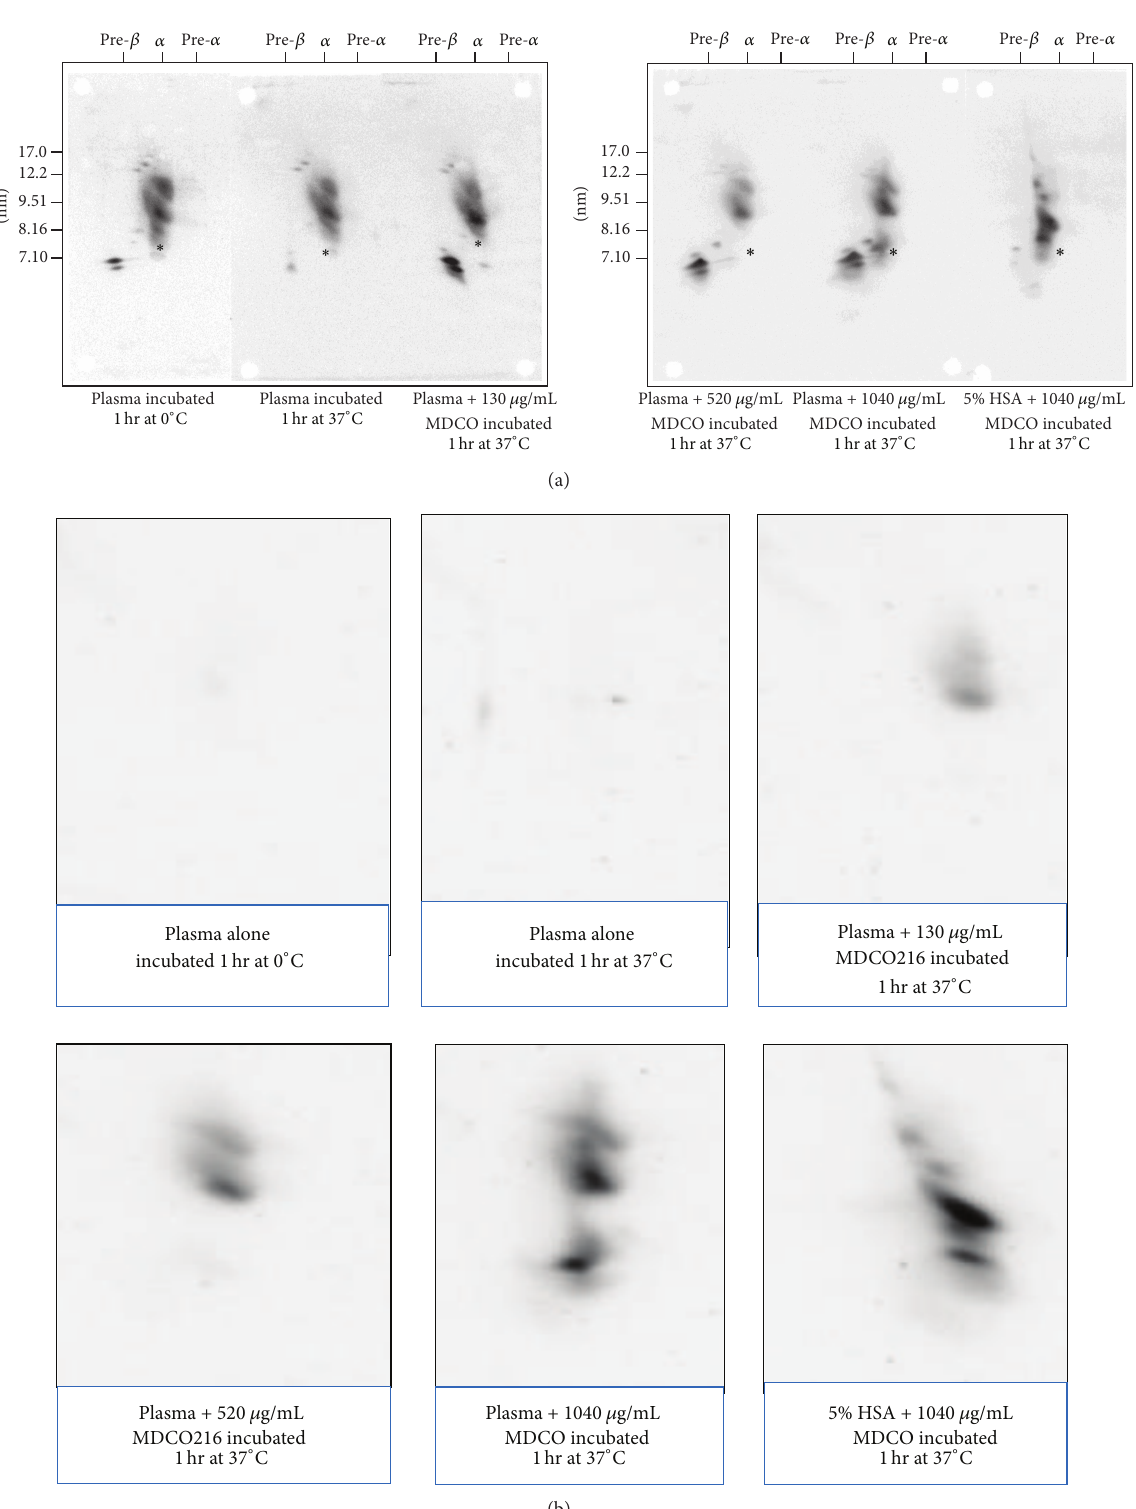
Figure 2: Effect of preincubation of human plasma alone or with MDCO-216 at 37 ∘ C. (a) After 2D electrophoresis, the blots were reacted polyclonal Ab against human apoA-I (also reacting with ApoA-I Milano). Asterisk denotes position of albumin. (b) 2D electrophoresis of the same samples of (a), with the blots now reacted with MAb 17F3 specific for ApoA-I